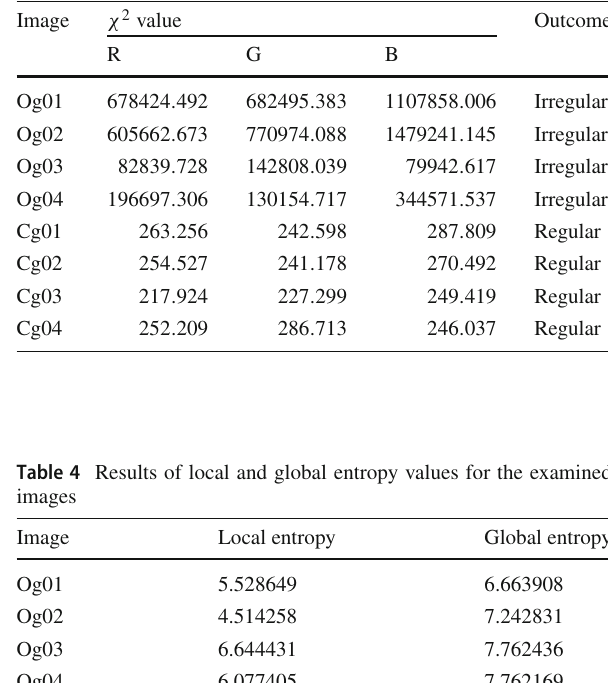
Table 3 Outcomes of χ 2 test for the examined dataset Image χ 2 value